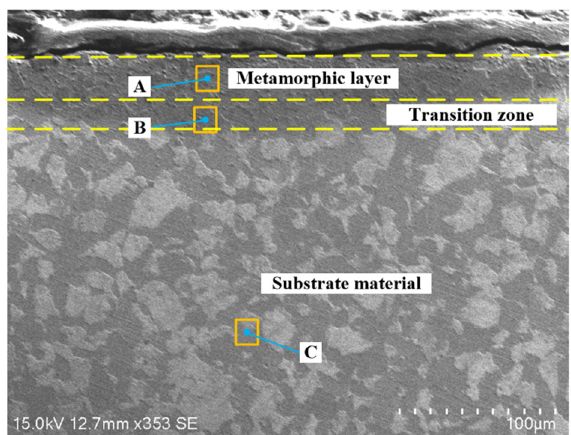
Figure 20. EDS detection area of metamorphic layer.